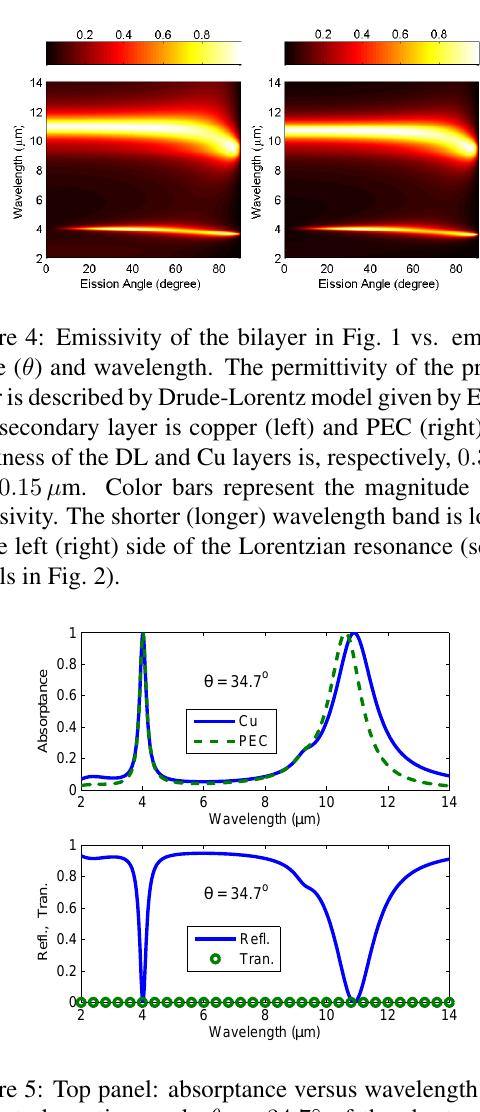
Figure 5: Top panel: absorptance versus wavelength at the perfect absorption angle θ = 34 . 7 ◦ of the shorter wave- length band when the substrate is Cu (blue-solid) and PEC (green-dashed). Bottom panel: reflectance (blue-solid) and transmittance (green-circles) of the DL/Cu bilayer versus wavelength at the corresponding angle. Simulation param- eters are the same as those in Fig.